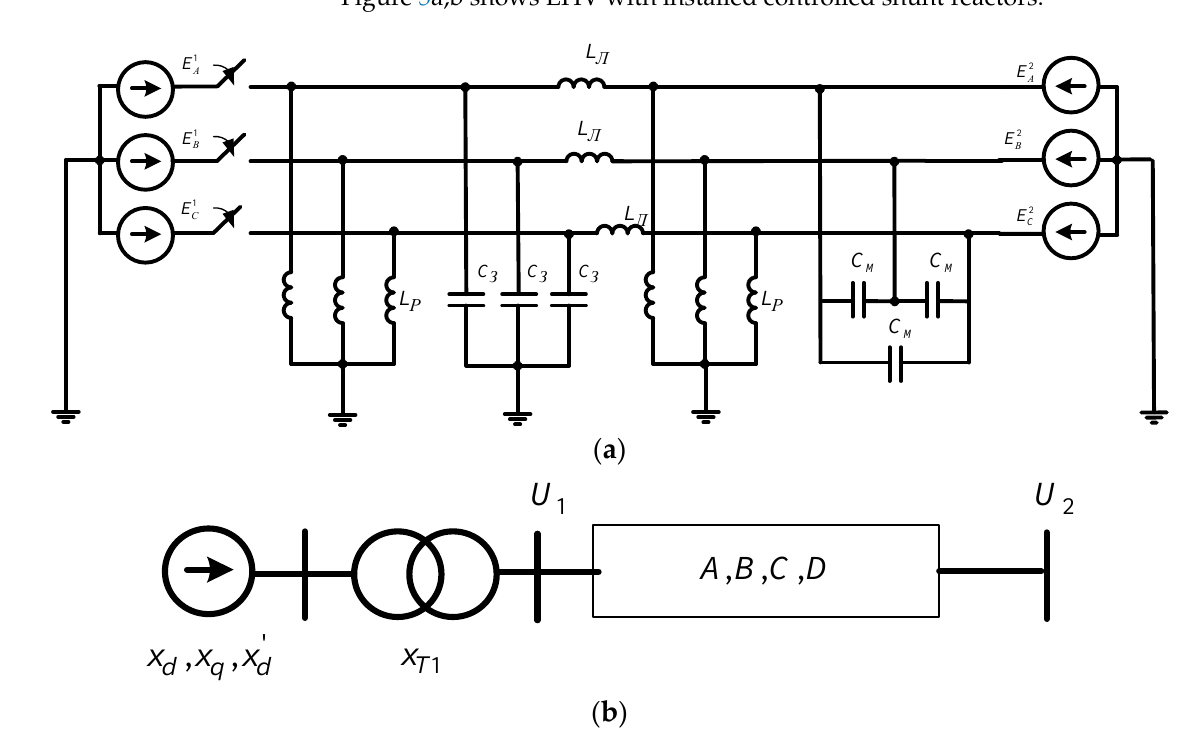
Figure 5. Schematic representation of a line with installed controlled shunt reactors: ( а ) is equivalent circuit of an extra-high voltage transmission line with an uncontrolled shunt reactor and ( b ) is schematic representation of a power line with generator values along the longitudinal and transverse axes.